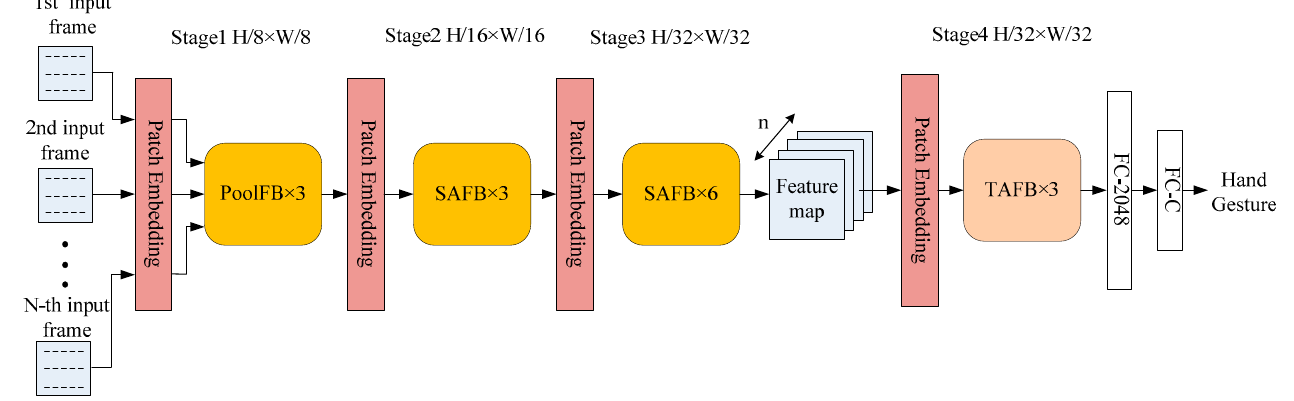
Figure 1. Framework of the proposed method.